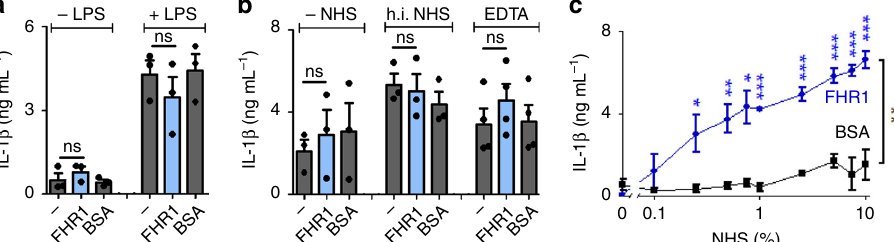
Fig. 2 FHR1-induced in fl ammation depends on immobilization and NHS. a Unbound FHR1 fails to increase secretion of IL-1 β by monocytes. b In the absence of NHS or in the presence of heat-inactivated (h.i.) and EDTA-inactivated NHS (EDTA), immobilized FHR1 does not induce IL-1 β secretion. c FHR1 induces secretion of IL-1 β upon exposure to 0.25% NHS. Increasing the concentration of NHS increases IL-1 β release. Data in a – c represent the mean ± SEM. of three to four independent experiments with different donor cells. * p ≤ 0.05, ** p ≤ 0.01, *** p ≤ 0.001 (unpaired two-tailed t